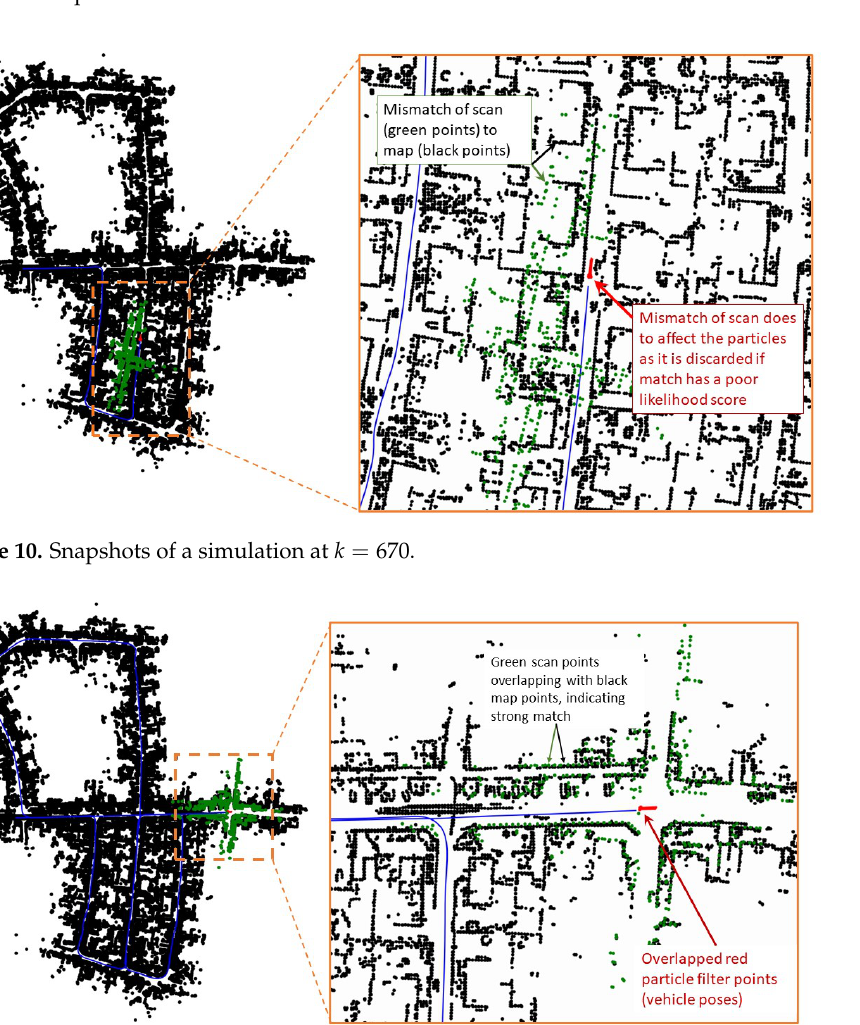
Figure 9. Snapshots of a simulation at k = 471.